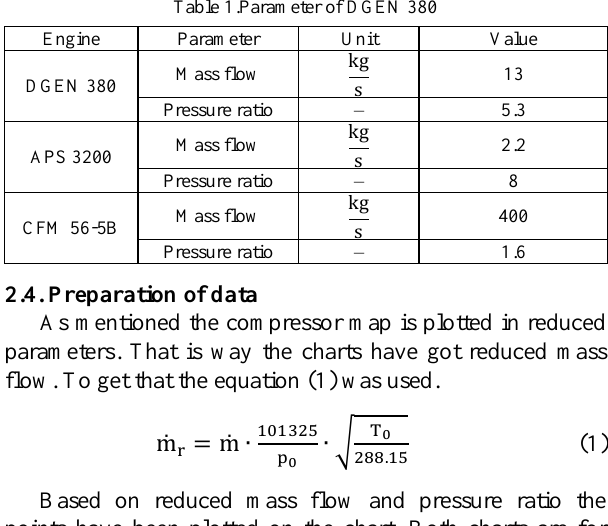
Fig. 1. Axial compressor map with reduced parameters [1]